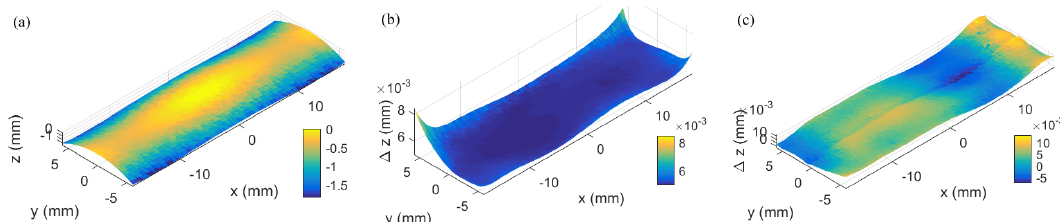
Figure 26. Mean surface, associated uncertainty and deviation from reference data after data fusion: ( a ) mean surface; ( b ) associated uncertainty; and ( c ) deviation from reference data.